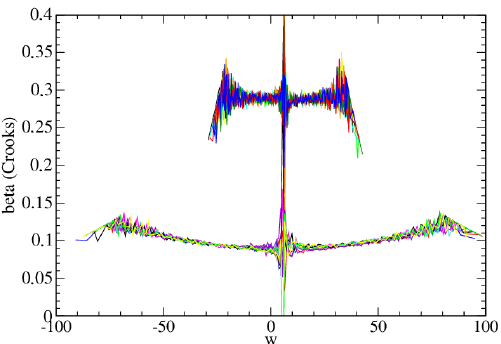
Figure 5. Figure gives β CR as a function of the work w calcu- lated with the CR Eq. (80), for exp1 (upper graph) and exp2 (lower graph). For each experiment 10 statistically independent realiza- tions are superposed.